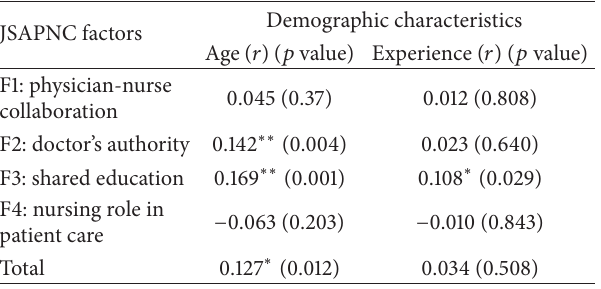
Table 6: Correlation coefficient between nurse physician collabora- tion factors and demographic characteristics. Demographic JSAPNC factors